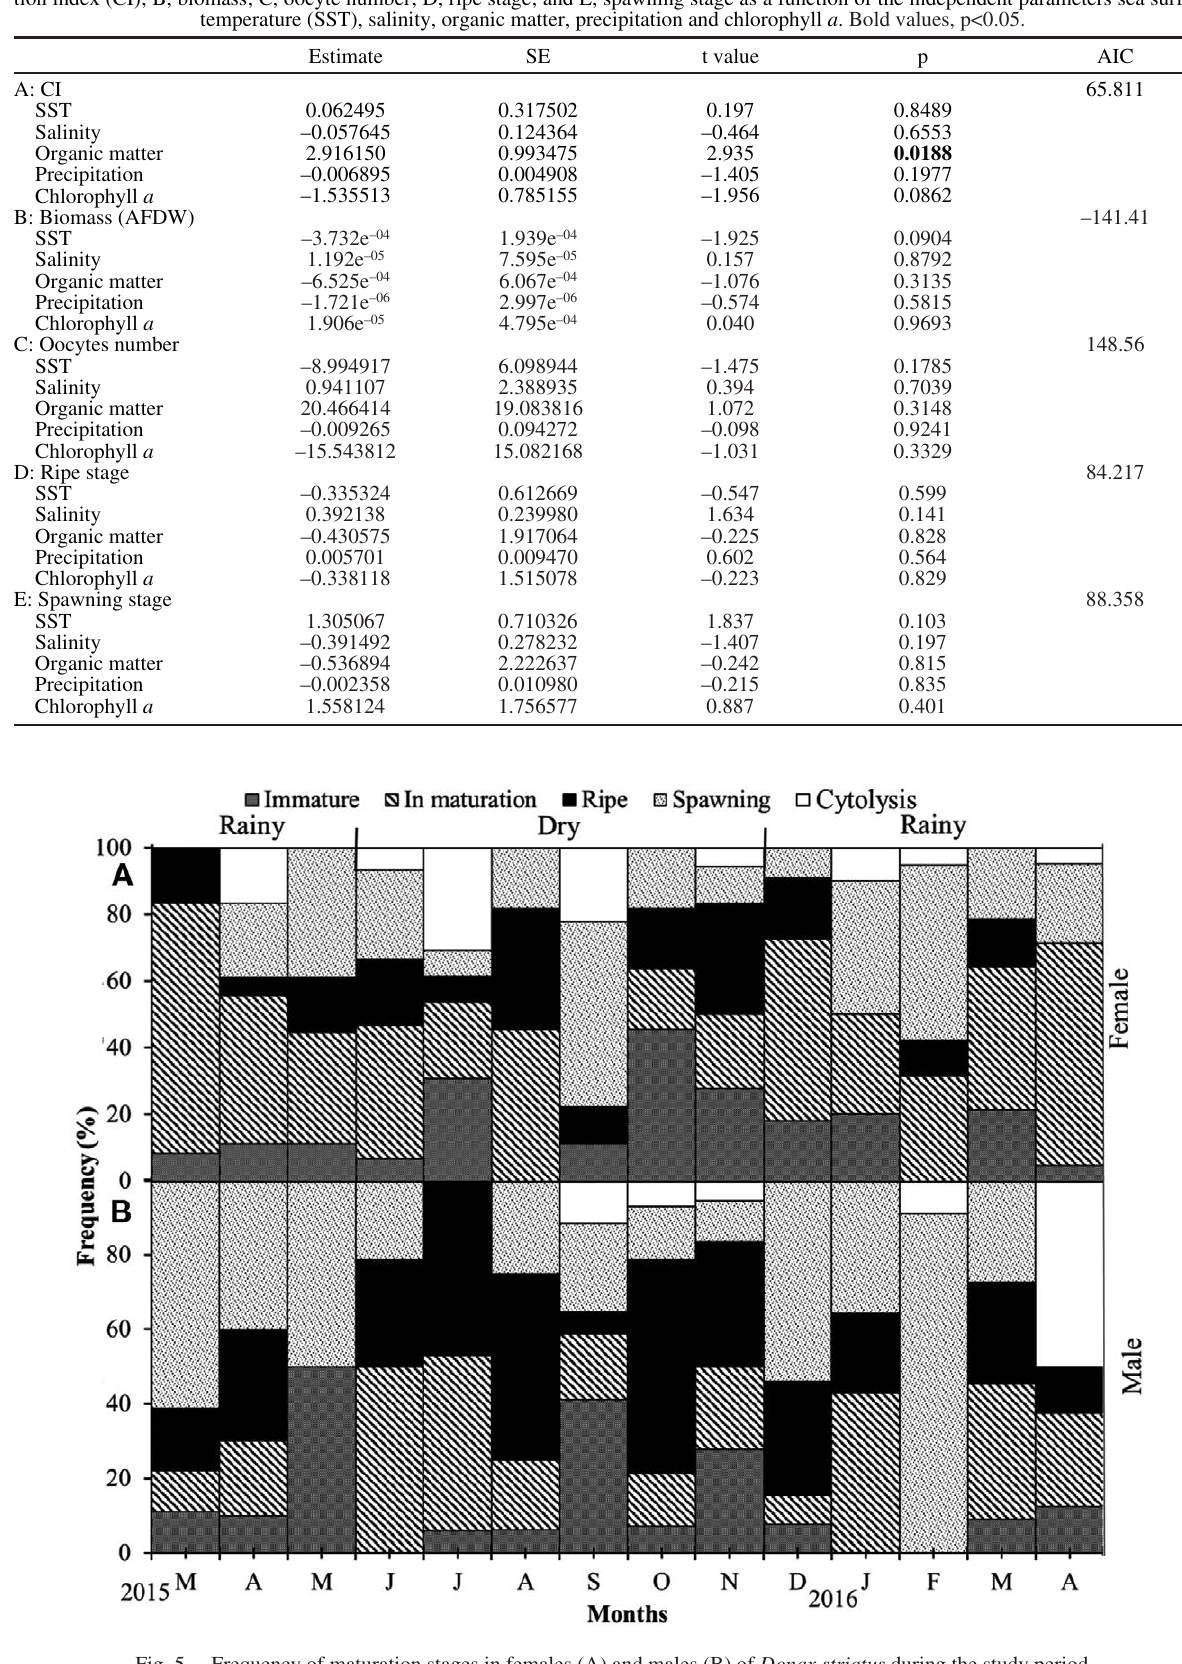
1. – Estimated coefficient and standard error (SE) of generalized linear model routines, applied to the dependent variables: A, condi- tion index (CI); B, biomass; C, oocyte number; D, ripe stage; and E, spawning stage as a function of the independent parameters sea surface